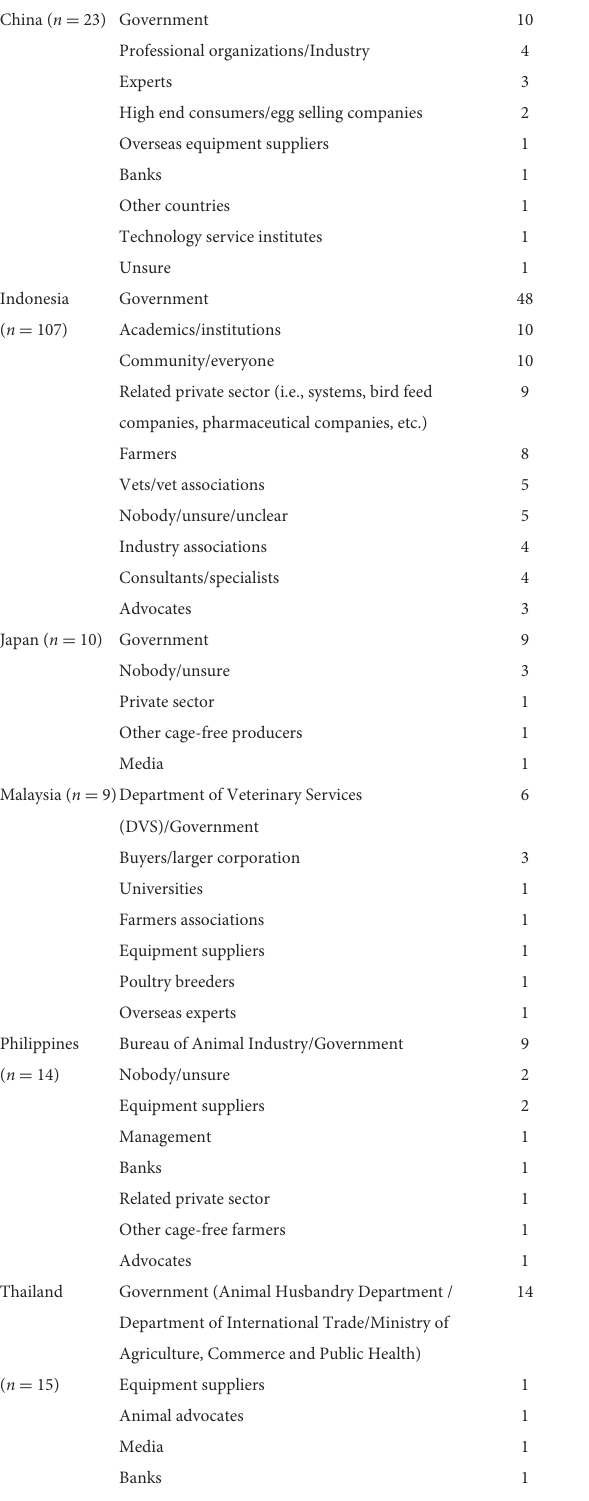
TABLE 6 Frequency of egg producers’ perceptions around who should be offering the support listed should they transition to cage-free